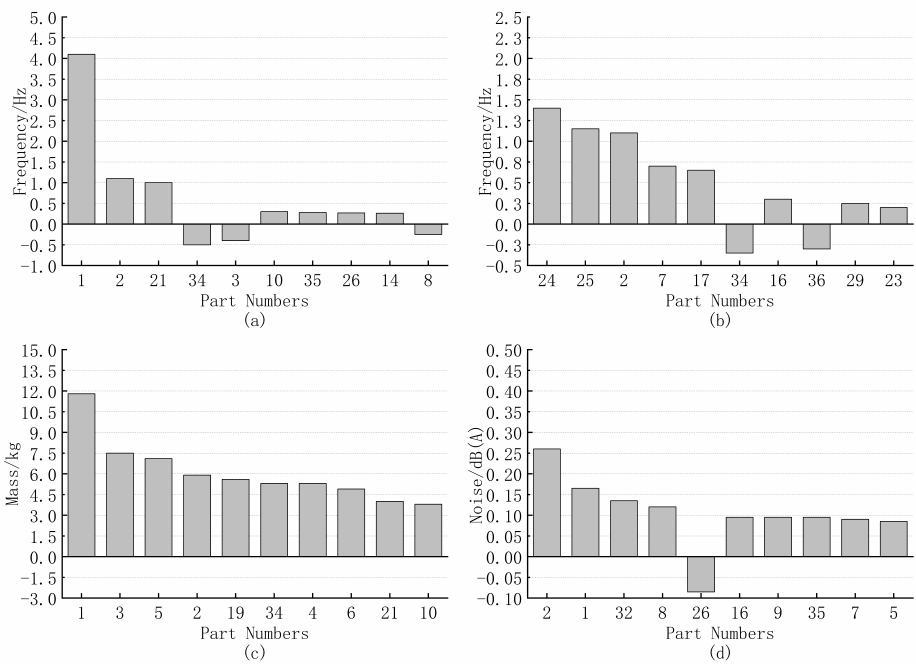
Figure 10. Panel sensitivity: ( a ) first order bending modal sensitivity. ( b ) First order torsional modal sensitivity. ( c ) Body mass sensitivity. ( d ) Maximum sound pressure level sensitivity. As shown in the figure, panels with high response and negative sensitivity are ob- tained. The B-pillar inner panel is determined via side impact simulation analysis, and the side wall, B-pillar inner panel, C-pillar inner panel, middle bottom panel, rear bottom panel, tail-light inner panel, A-pillar inner panel, and roof are identified as panels that require optimization. The value ranges of the panels are shown in Table